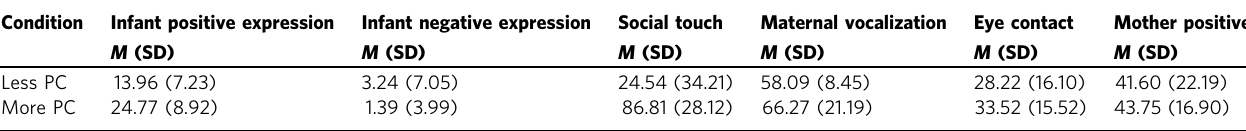
Table 4 The mean and standard deviation of the duration percentage of maternal and infant behaviors observed in the mother – infant